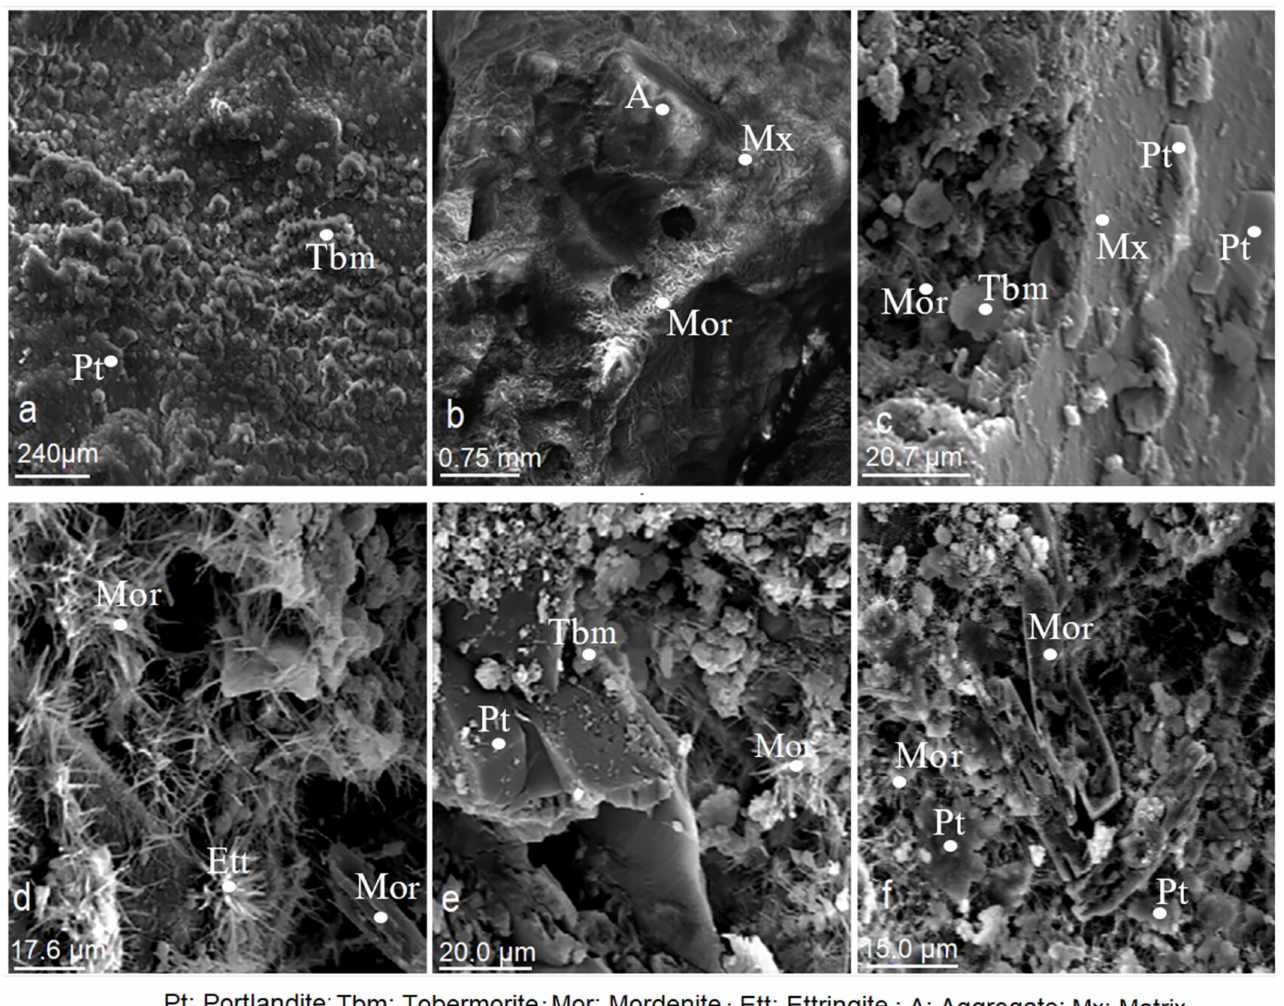
Figure 15. ( a – f ). Microphotographs of cement/mordenite (CMS) specimens taken at 28 days of